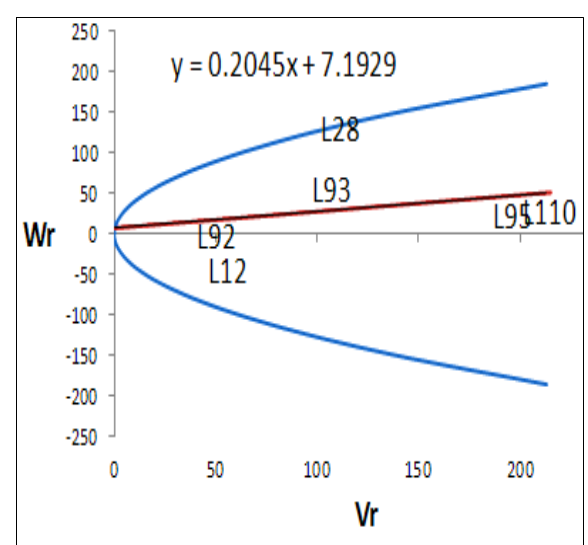
Fig. 2a: Wr/Vr graphs for plant height under NI Fig. 2b: Wr/Vr graphs for plant height under WSC